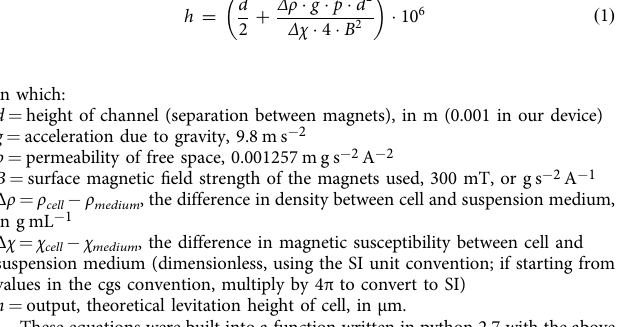
Fig. 2f were computed with the predicted heights as described above, and a normal distribution was generated using Python ’ s numpy module, with cell population size taken from typical cell dilutions and the variance in levitation heights derived from the typical range of red blood cell densities. Further details can be found below in “ Detailed methods: explanation of custom code and algorithms: part A ”